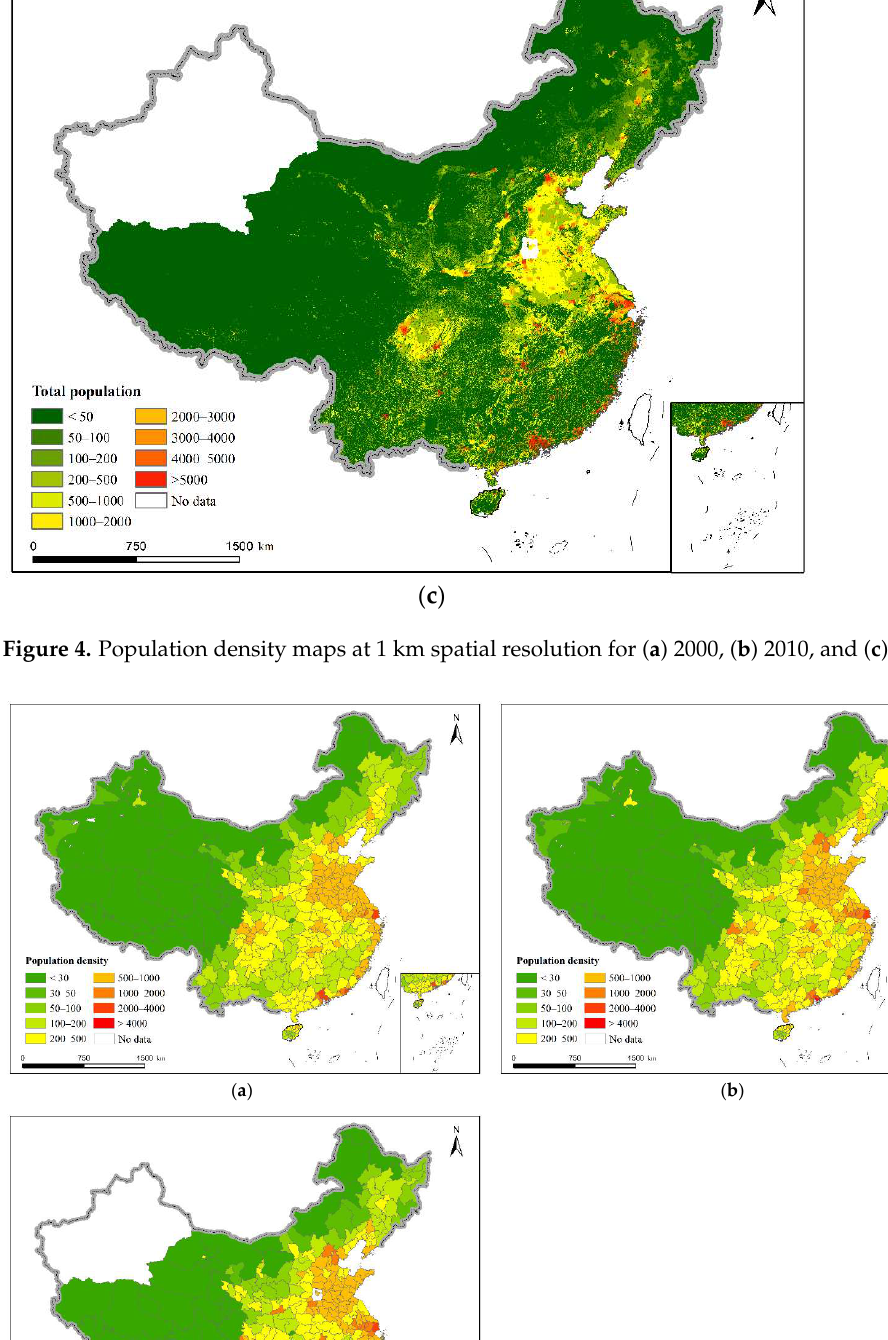
Figure 5. Results of the average population density for the urban level in China in ( a ) 2000, ( b ) 2010, and ( c ) 2020.